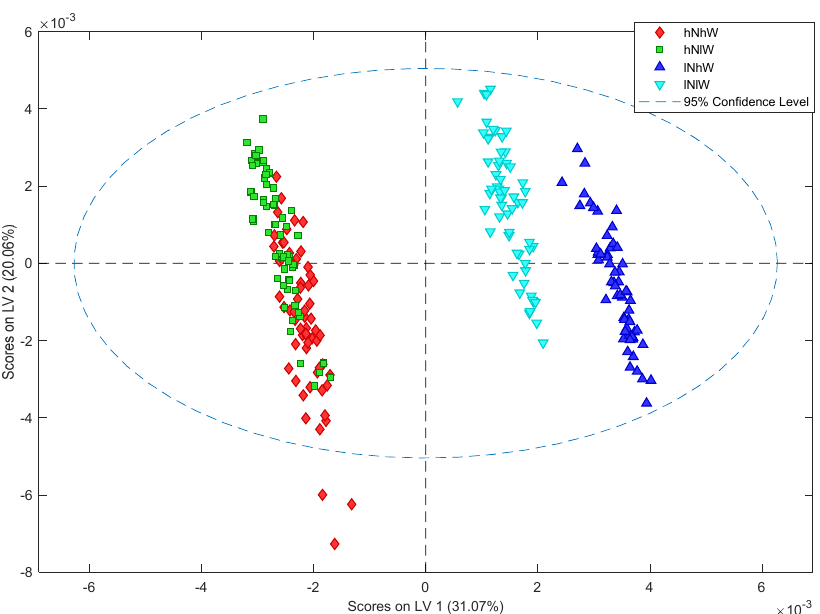
Figure 3. PLS-DA scores plot of 1 H NMR data showing the major effect of nitrogen treatment on Nonpareil hull samples with significant water treatment influence on restricted nitrogen samples. Error of classification on cross validation: high N high W 17%, high N low W 21%, low N low W 11%, low N high W 19%.